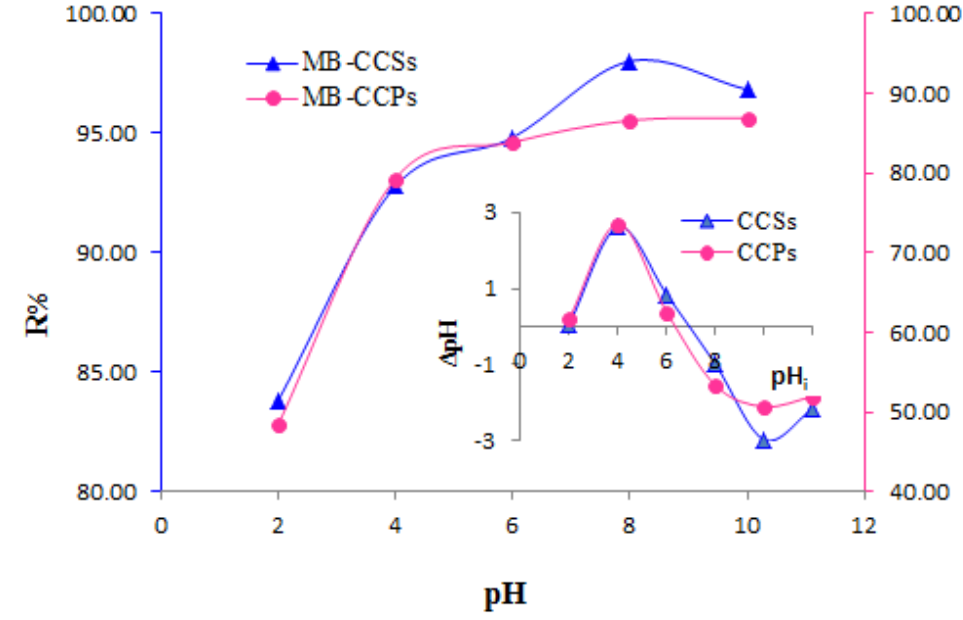
Figure 7. Effect of pH on MB removal efficiency using CCSs and CCPs (Inset–pH PZC ).